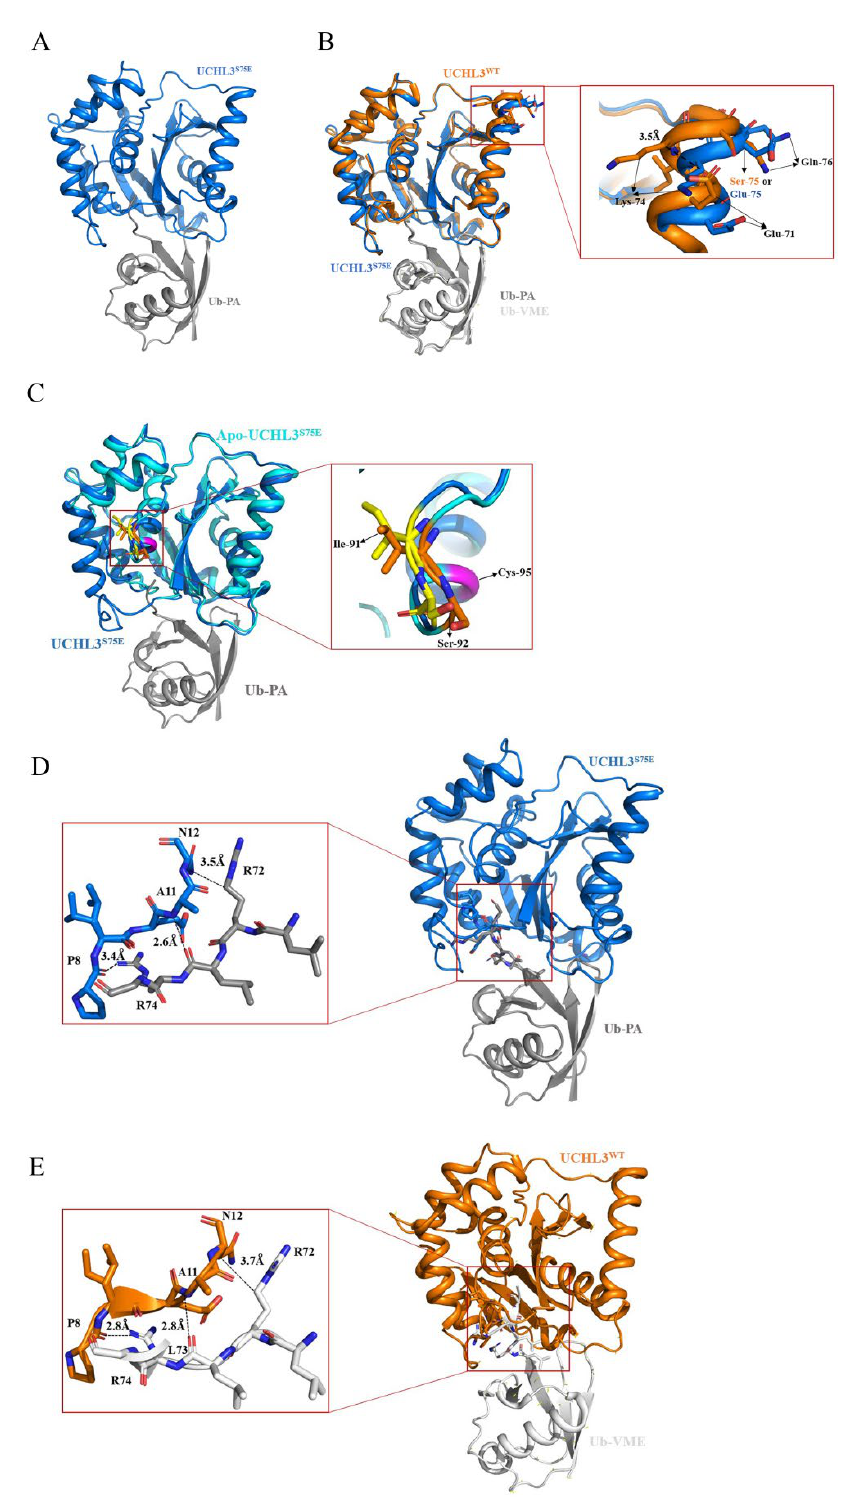
Figure 2. Crystal structure of UCHL3 S75E bound to Ub-PA. In all panels, UCHL3 S75E is in blue, UCHL3 WT is in orange, and Ub-PA and Ub-VME are in gray and white, respectively. ( A ) Overview of the structure of UCHL3 S75E -Ub-PA in a cartoon representation. ( B ) Structural changes near the phosphorylation site of complex UCHL3 S75E -Ub-PA. ( C ) Structural changes near the active site between UCHL3 S75E -Ub-PA and apo’s UCHL3 S75E ; yellow and orange represent amino acid residues Ile91 and Ser92 of UCHL3 S75E -Ub-PA and UCHL3 S75E , respectively. ( D ) Interaction of UCHL3 S75E with the C terminus of ubiquitin. ( E ) Interaction of UCHL3 WT with the C terminus of